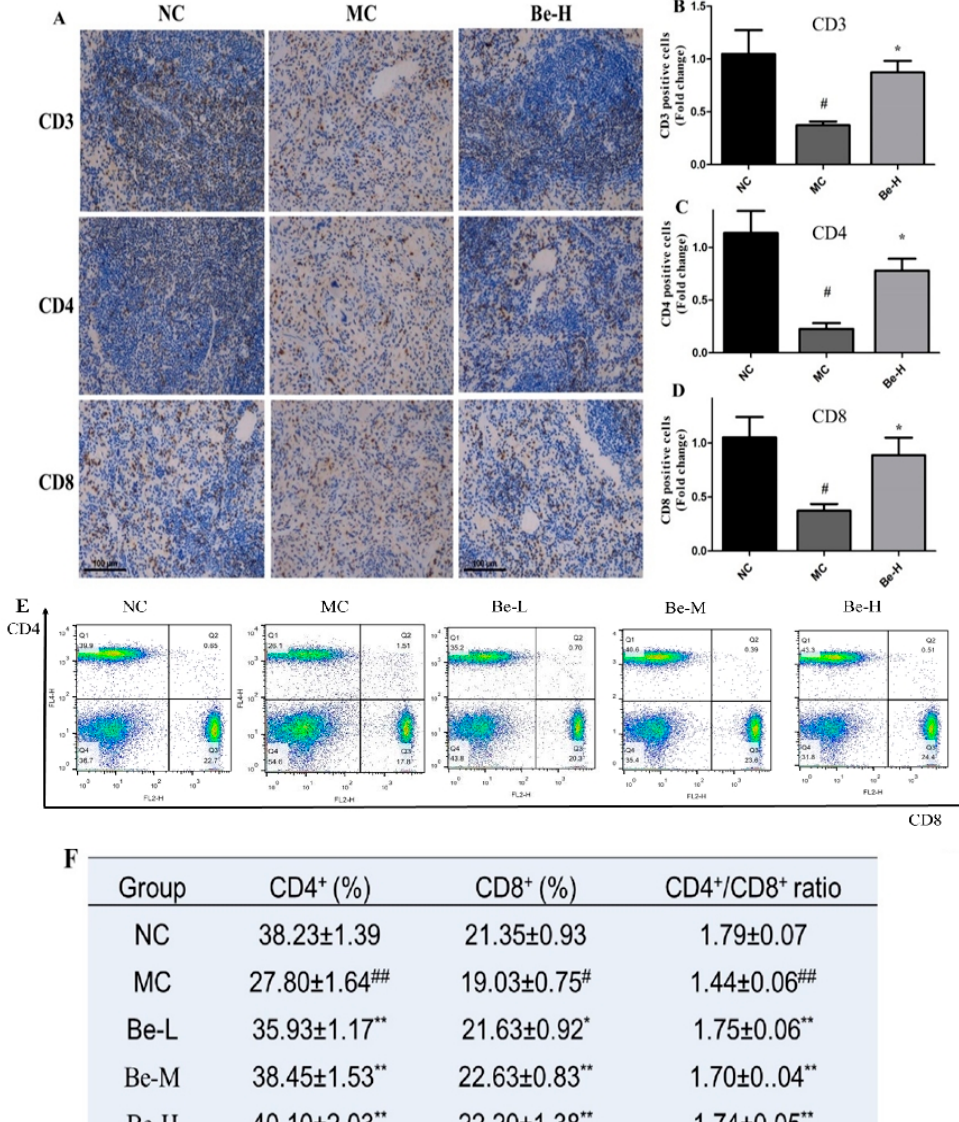
Figure 4. Effects of bergenin on splenic T lymphocyte subsets in the Cy-treated mice. ( A ) CD3 + , CD4 + and CD8 + T lymphocyte expression in spleen tissues. ( B ) Bar graphs represent mean ± SEM of the numbers of CD3 + -positive cells from five microscopic fields in each group. ( C ) Bar graphs represent mean ± SD of the numbers of CD4 + -positive cells from five microscopic fields in each group. ( D ) Bar graphs represent mean ± SEM of the numbers of CD8 + -positive cells from five microscopic fields in each group. ( E ) Splenic T lymphocyte subsets detected by flow cytometry. ( F ) Splenic T lymphocyte subpopulation analyzed by flow cytometry. NC: normal control group, dosed with saline; MC: model control group, challenged with cyclophosphamide; Be-L: challenged with Cy and treated with 5 mg/kg/day bergenin; Be-M: challenged with Cy and treated with 10 mg/kg/day bergenin; Be-H: challenged with Cy and treated with 20 mg/kg/day bergenin. Values are shown as mean ± SD ( n = 8). # p < 0.05, ## p < 0.01 vs. the NC group, * p < 0.05 and ** p < 0.01 vs. the MC